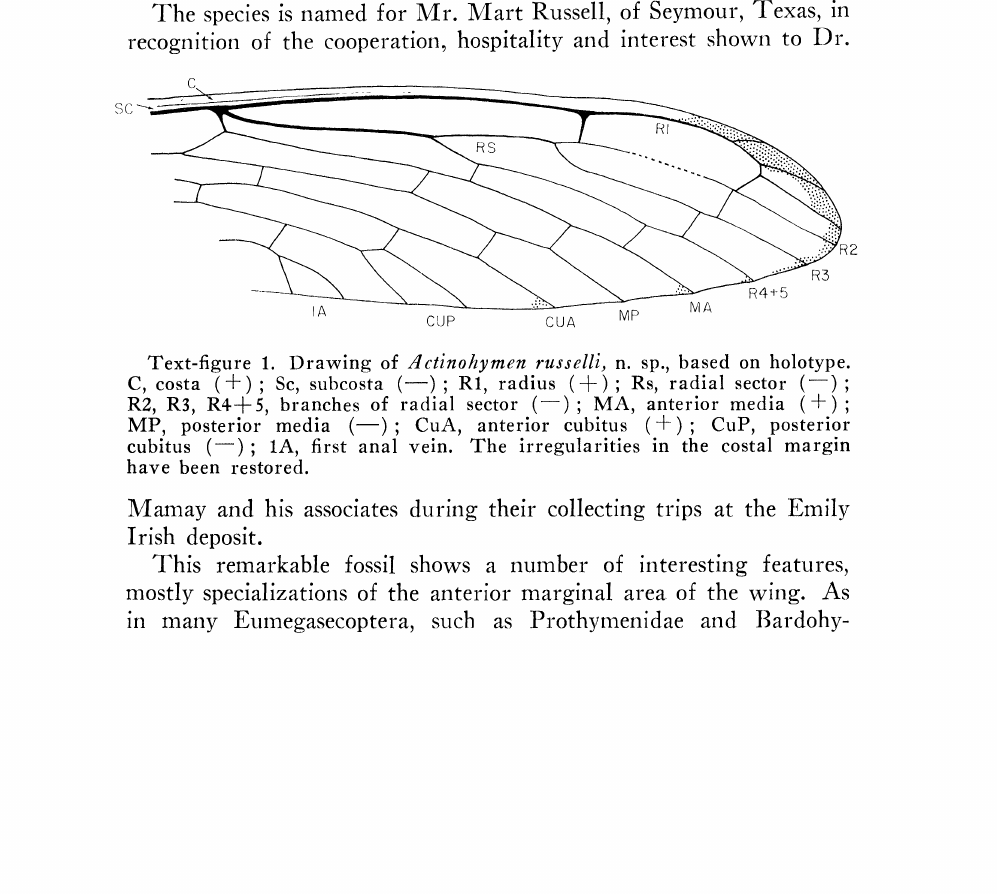
Psyche apical region margined with dark pigment; isolated triangular spots at end of R4+ 5, MA, and CuA. tight outer cross-veins, forming a distinct row; CuP and IA forked distally. Other details of vena- tion are shown in text-figure I.